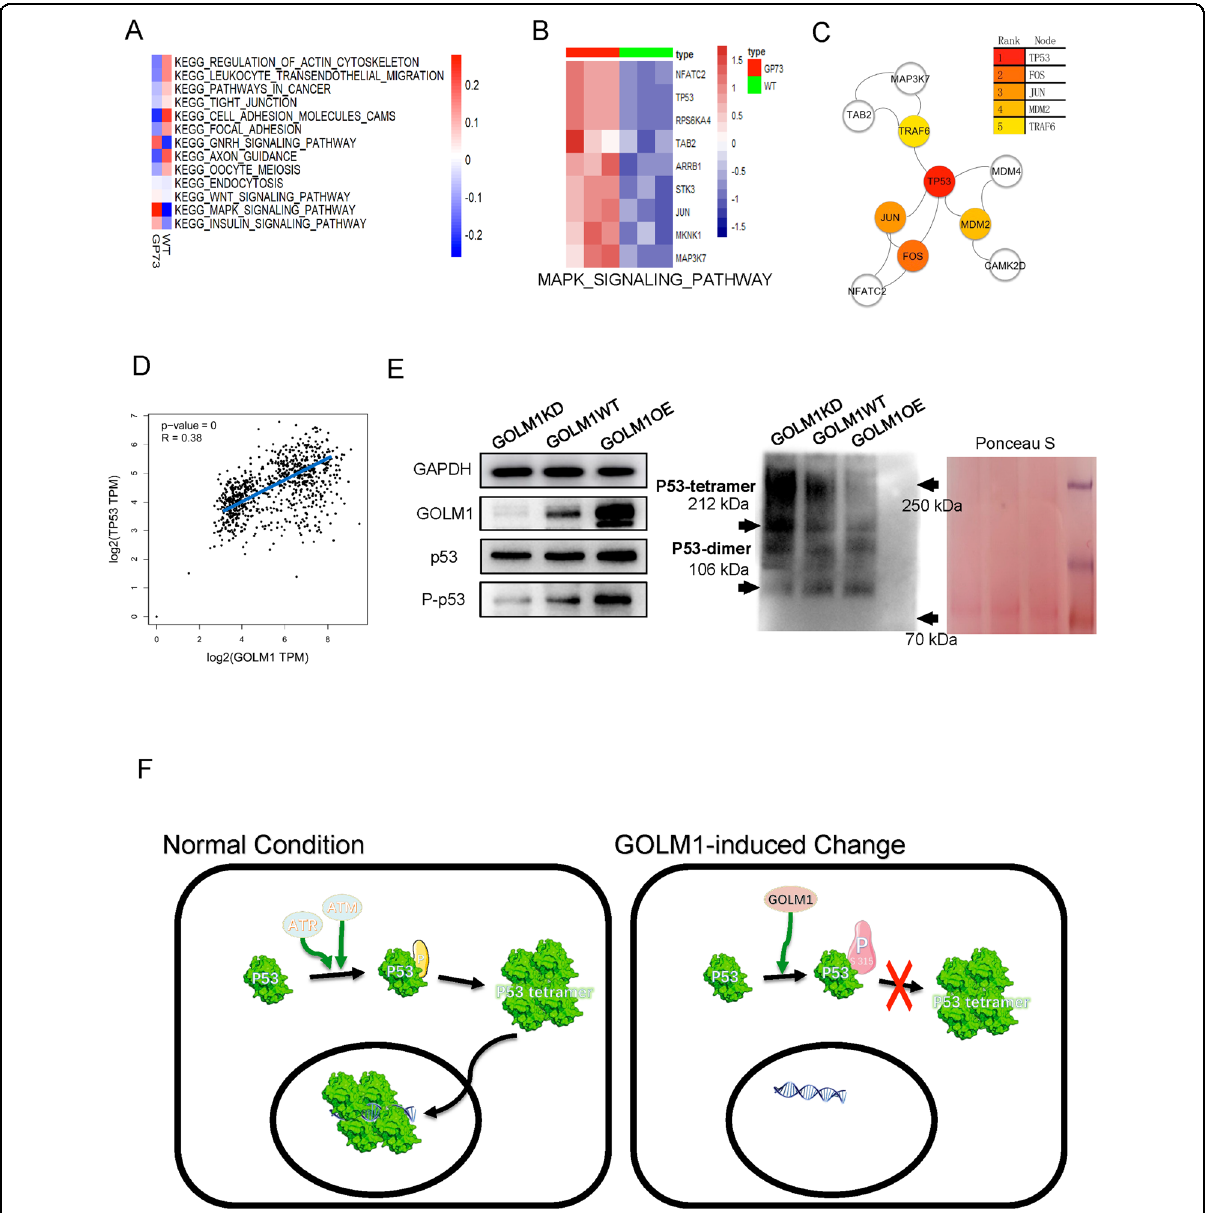
Fig. 6 GSEA reveals that GOLM1 promotes growth of lung cancer cells via regulating tetramer formation of P53. A GSEA results of KEGG pathway cluster analysis from phosphoproteomics data. B The expression level of members in MAPK signaling pathway enriching from GSEA result. C Protein – protein interaction (PPI) of hub genes in MAPK signaling pathway. D Pair-wise gene expression correlation analysis between GOLM1 and TP53. E Western blot results of expression level of P53, S315 Phos-P53 protein, and P53 tetramer protein in three groups from GOLM1KD, GOLM1WT, and GOLM1 OE PC9 cells (GOLM1, P53, S315 Phos-P53 protein were separated by SDS-PAGE; P53 tetramer (212kDa) and P53 dimer (106 kDa) protein were separated by native-PAGE). F Mechanism of GOLM1 promotes growth of lung cancer cells through regulating tetramer formation of P53. GOLM1KD GOLM1 knockdown group, GOLM1WT wild-type group, GOLM1OE GOLM1 overexpression